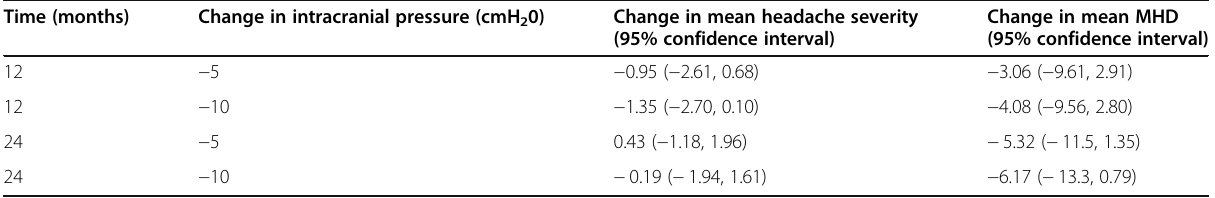
Table 3 Predicting changes in headache severity and monthly headache days from changes in intracranial pressure Time